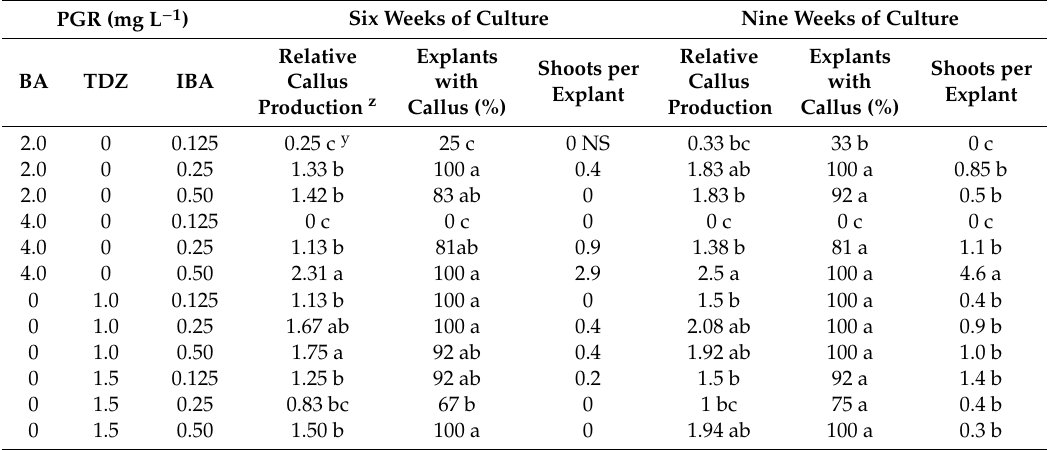
Figure 2. Shoot formation in ‘Baron Solemacher’ leaf discs treated with 6-benzylaminpurine (BA; 4.0 mg L − 1 ) plus indolebutyric acid (IBA; 0.5 mg L − 1 ). ( a ) Callus formation after six weeks in culture, ( b ) shoot formation after nine weeks, ( c ) abaxial side up with BA (4.0 mg L − 1 ) plus IBA (0.5 mg L − 1 ), ( d ) adaxial side up with BA (4.0 mg L − 1 ) plus IBA (0.5 mg L − 1 ), ( e ) plantlets, and ( f ) rooted plantlets. Table 3. Effects of BA, TDZ, and IBA on relative callus formation z , % explants with callus, and shoots per explant from seedling leaf explants of Fragaria vesca cv. Baron Solemacher.